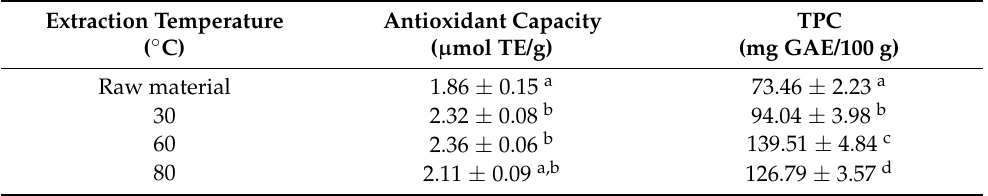
Table 4. Antioxidant capacity and TPC of the selected